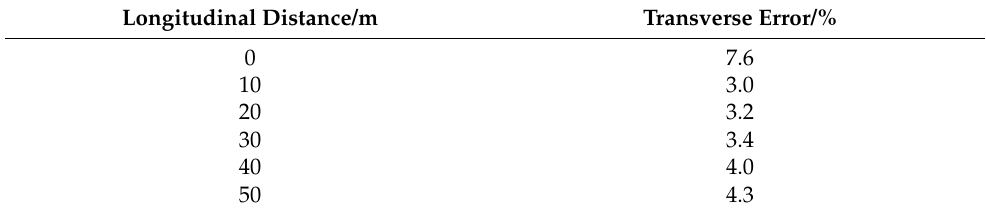
Table 4. Result of mapping.